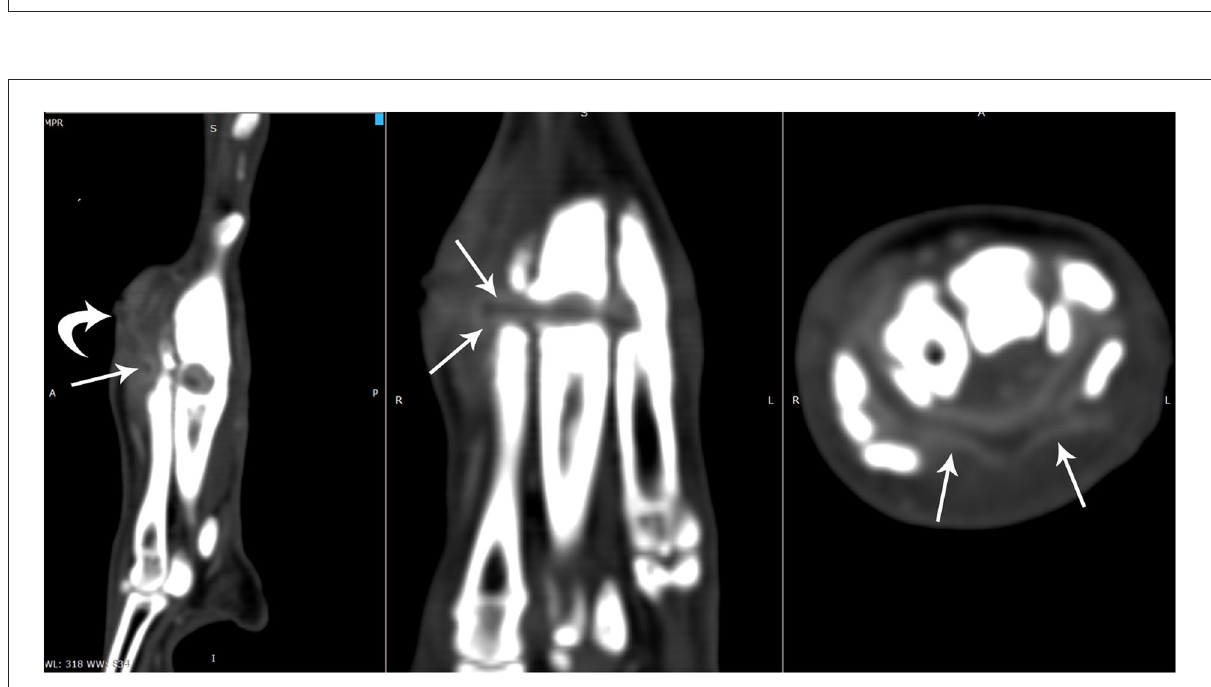
FIGURE4 On the post-contrast multiplanar computed tomographic images obtained in a soft tissue window, the non-contrasting tubular structure (arrow) appeared to be adjacent to a soft tissue tract with mild contrast enhancing walls dorsomedial to the 2nd metatarsal bone (curved arrow). There was strong contrast enhancement surrounding a non-contrast enhancing tubular structure (arrows) which circumferentially coursed through the areas of bone lucencies and soft tissues and continued along the plantar region between the interosseous muscles and the flexor tendons. The flexor tendons appeared indistinct in this